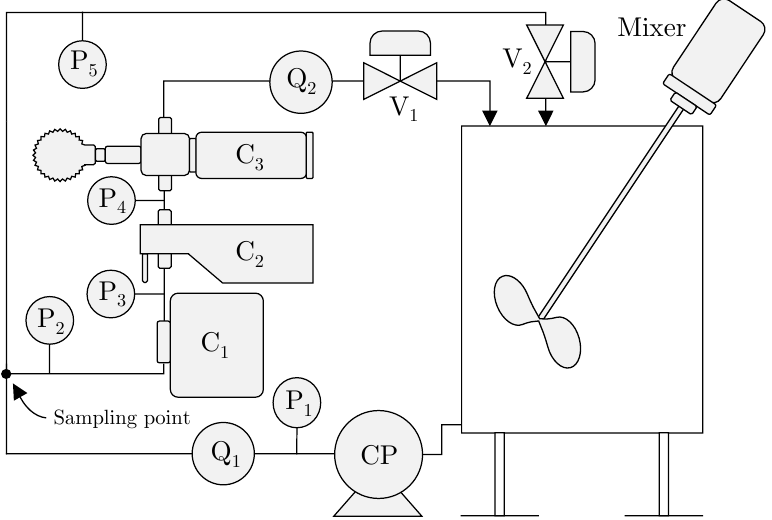
Figure 2. Skid mounted testing platform for validating quality monitors’ performance on a sidestream installation during different flow